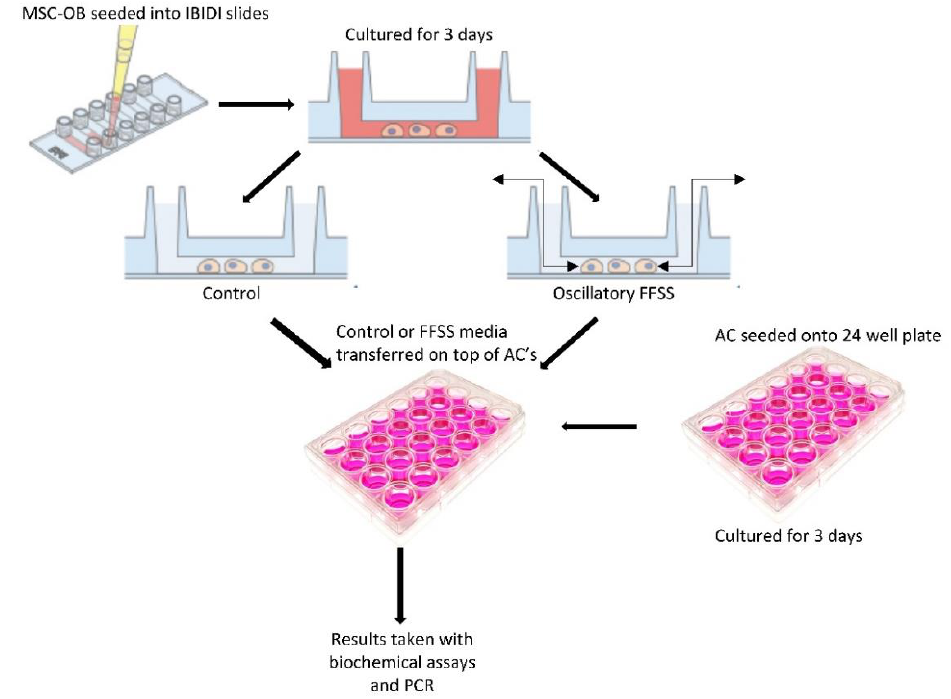
Figure 6. Schematic of conditioned media experiments. Cells were seeded into IBIDI slides, cultured for 3 days prior to FFSS or sedentary control before conditioned media was collected and introduced. Adapted with permission from [51].